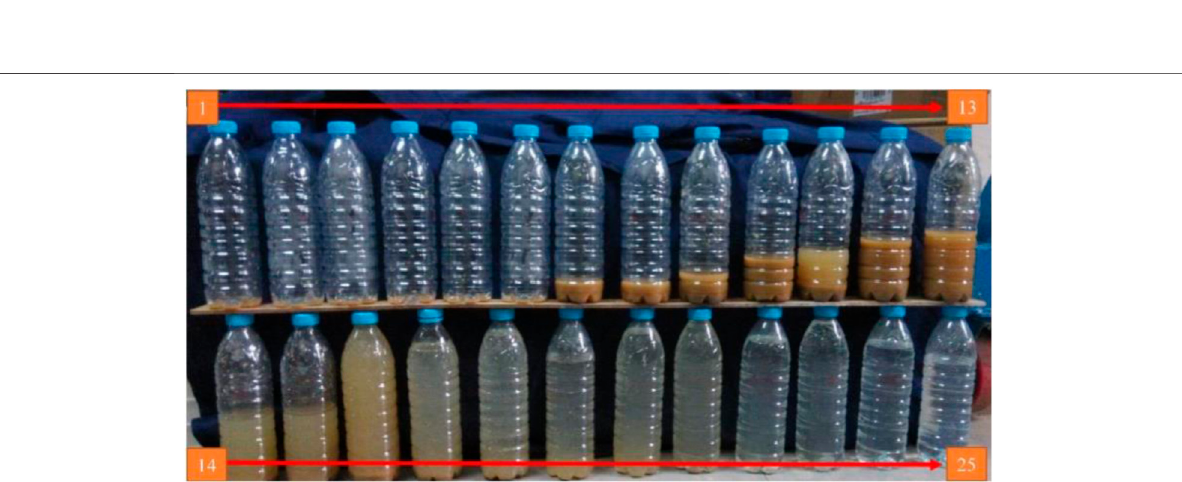
FIGURE 8 | In fl uence of particle size gradation on the evolution of the fi ne particle concentration: (A) time-varying curves of water gushing velocity with different power exponents and (B) time-varying curve of Reynolds number ( n (cid:1) 1.0).